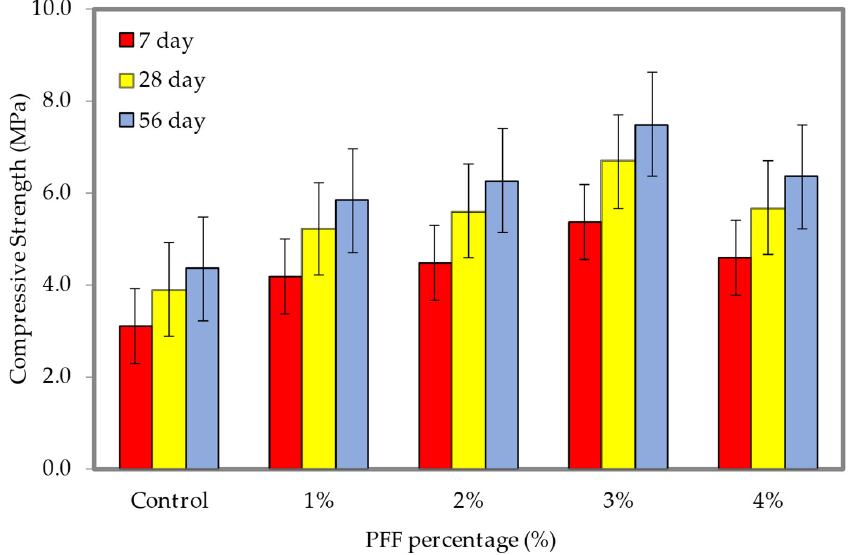
Figure 15. Compressive strength of foamed concrete of 1200 kg/m 3 density with varying PFF per- centages.